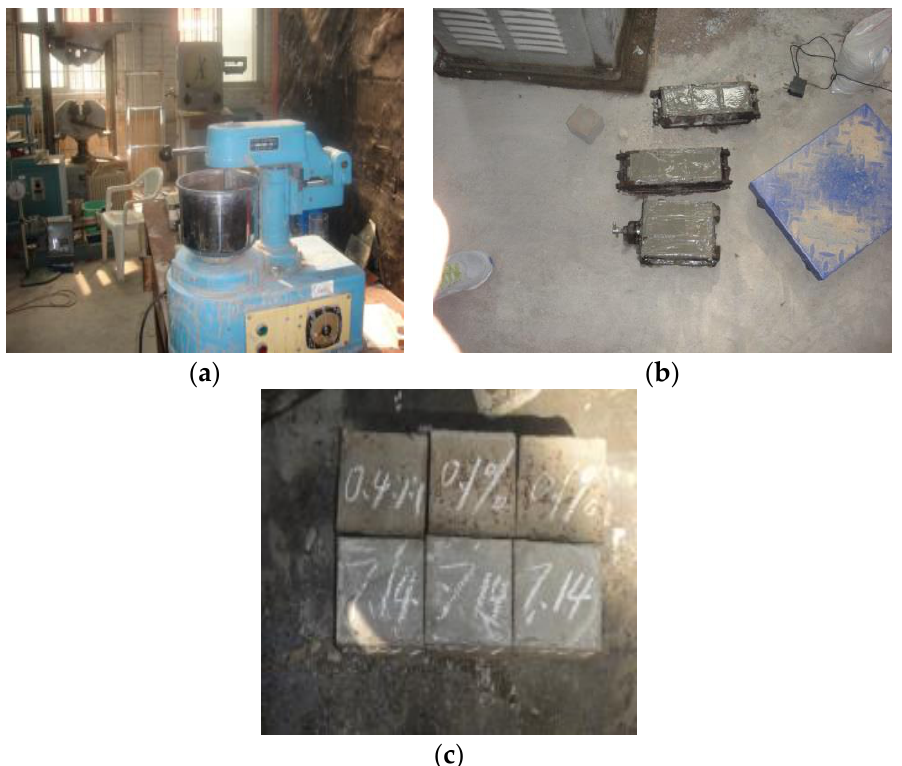
Figure 3. Preparation process of compressive strength test piece: ( a ) mixmaster; ( b ) test material preparation; ( c ) finished product.